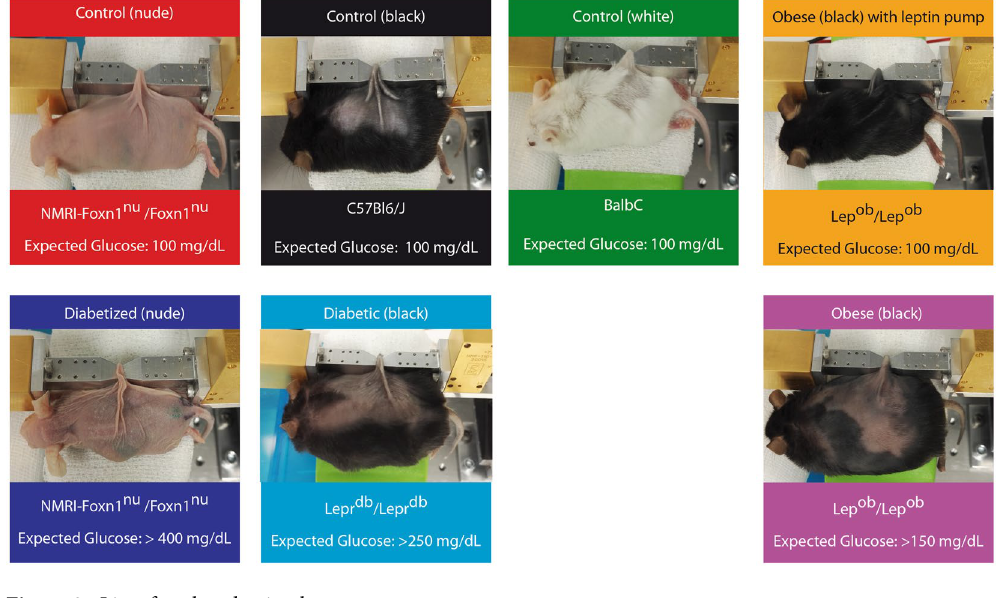
Figure 8. List of analyzed